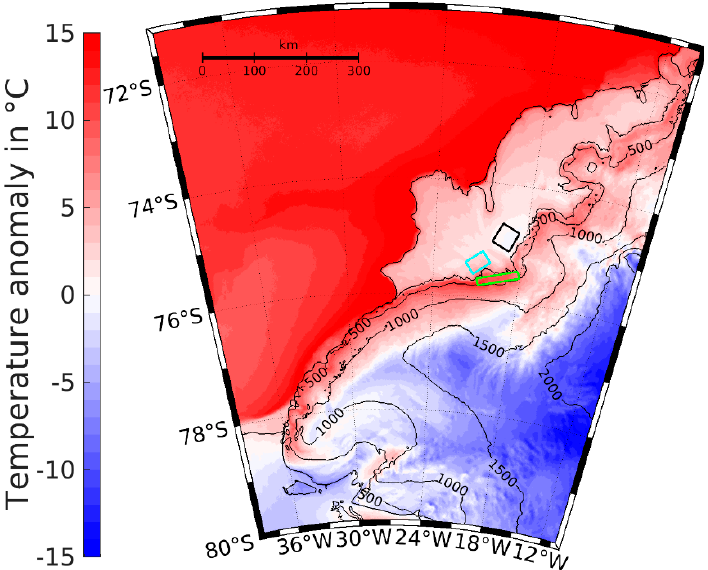
Figure 9. As Figure 6, but for the eastern Weddell Sea. The green box marks the slope area, the blue box marks the surge area, the black box marks the reference area.